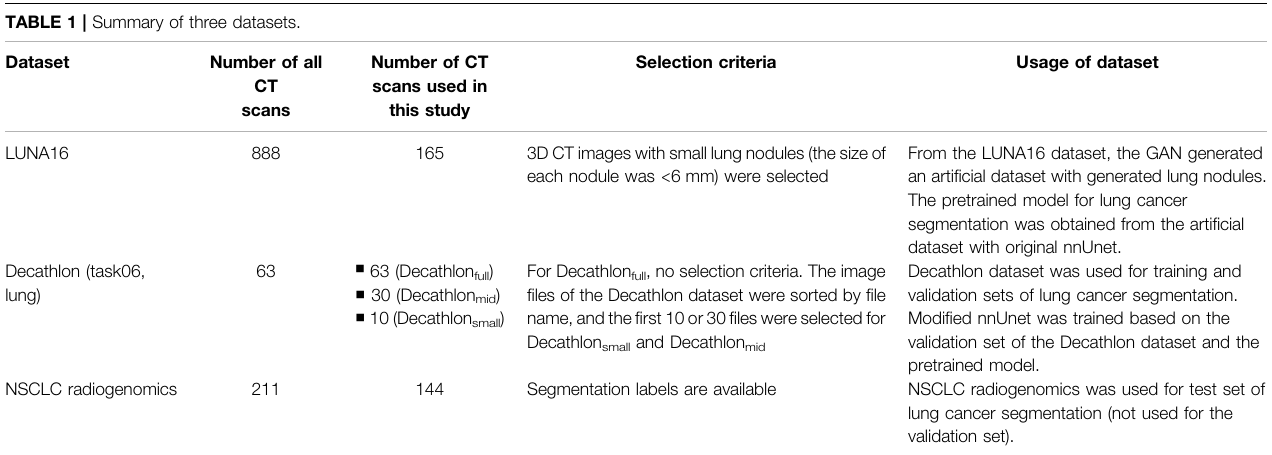
TABLE 1 | Summary of three